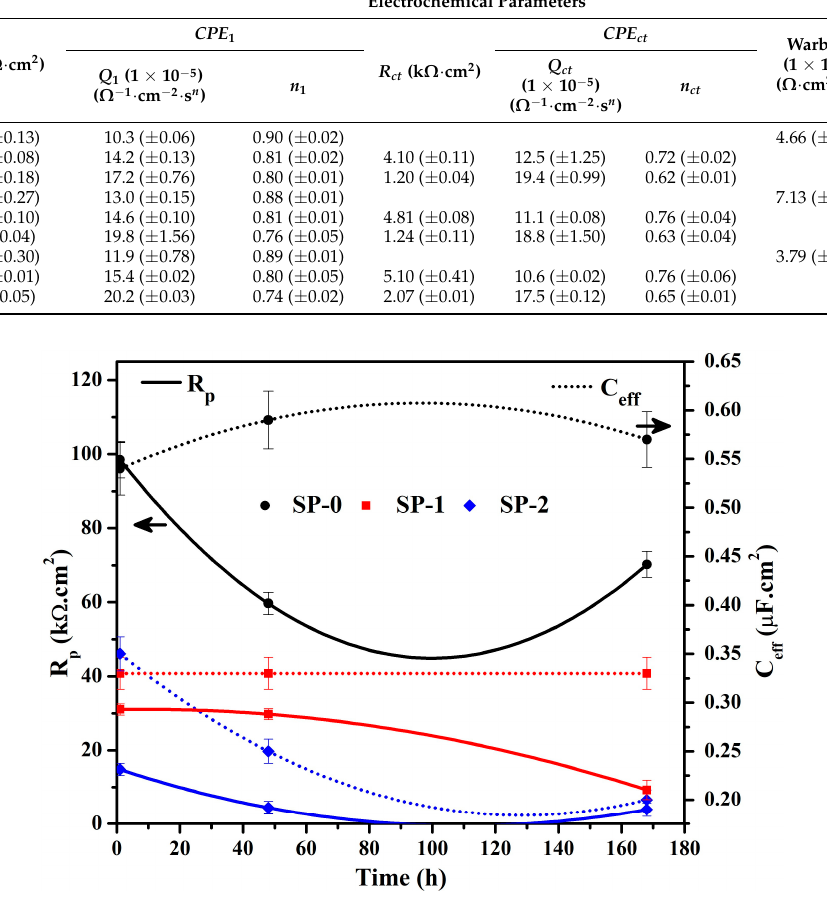
Figure 6. R p and C eff in different solutions with time.